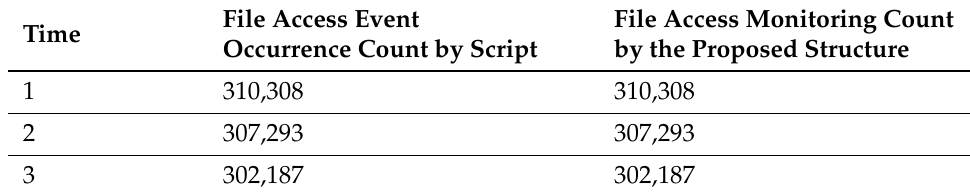
Table 6. File access event occurrence count and monitoring